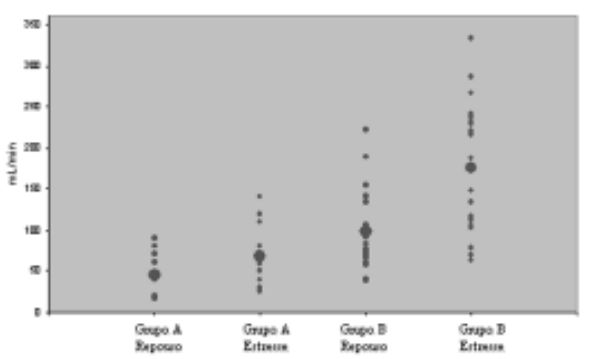
Fig. 5 - Dispersão dos valores dos débitos totais (DT), em ml/min, nos grupos A e B, em repouso e em estresse. As médias dos valores dos DT foram ressaltadas.